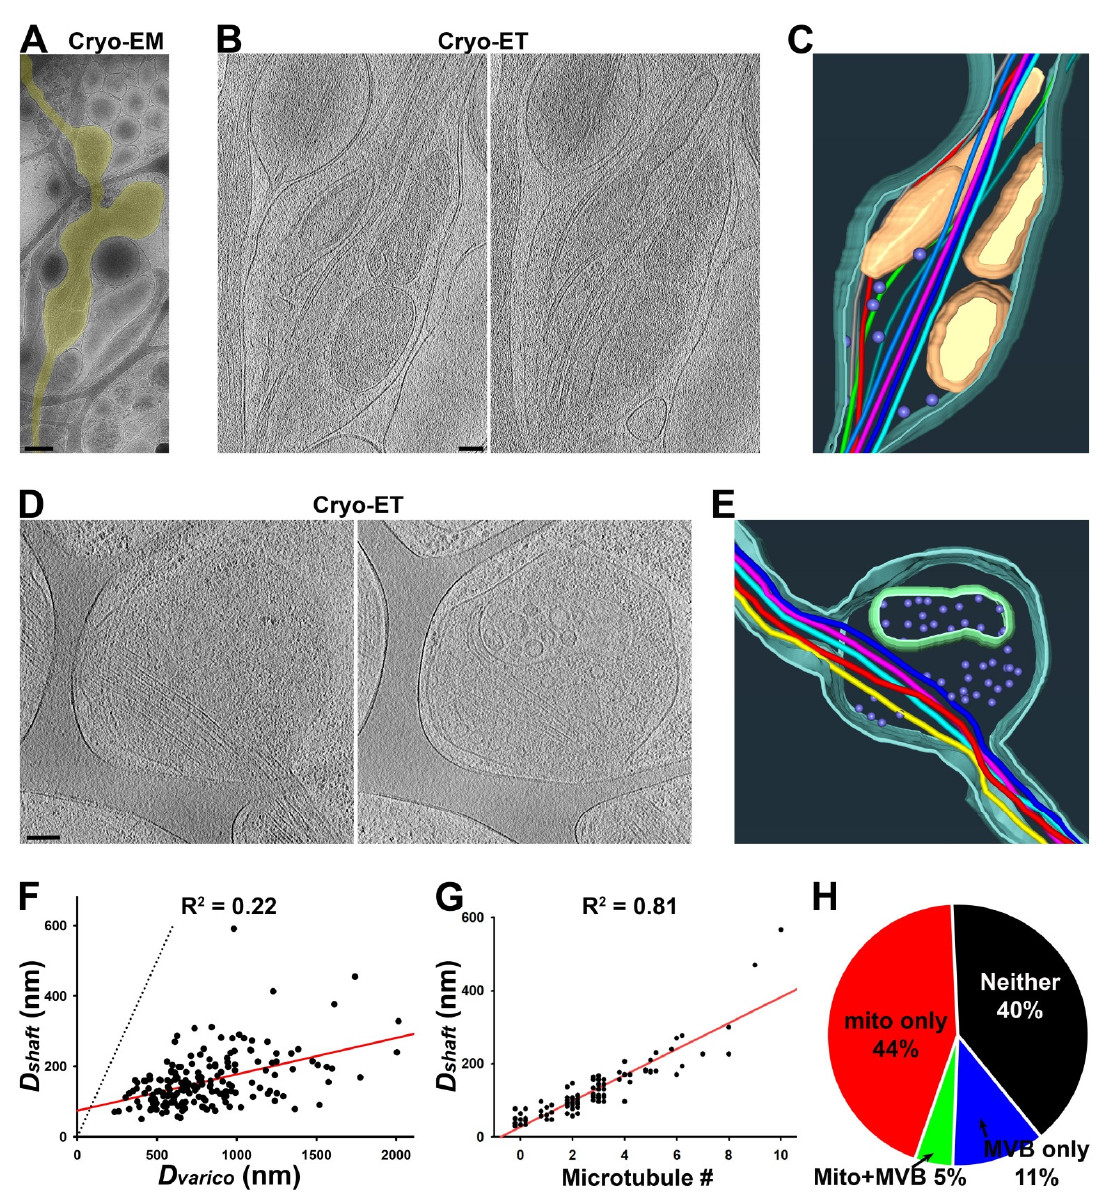
Figure 2. Three-dimensional ultrastructures of axonal varicosities on lacey carbon film revealed by Cryo-ET. ( A ) Low-magnification Cryo-EM image of an axon (highlighted in yellow) growing on lacey carbon film. ( B ) Two slices from the Cryo-ET tomogram of the axonal varicosity. ( C ) Segmentation view of the varicosity in ( B ). MTs were represented in tubes of different colors: mitochondria in yellow, plasma membrane in cyan, and small vesicles in purple. ( D ) Two slices from the Cryo- ET tomogram of an axonal varicosity containing an MVB. ( E ) Segmentation view of the varicosity in ( D ). The outer membrane of the MVB is in green. ( F ) The correlation between the diameter of the axonal varicosity (D varico ) and the diameter of its nearby shaft growing on top of carbon fiber (D shaft ). ( G ) The correlation between the diameter of the axonal shaft (D shaft ) and the number of its MTs. ( H ) Percentages of axonal varicosities containing mitochondria but not an MVB (red, 44%), MVB(s) but no mitochondria (blue, 11%), both mitochondria and an MVB (green, 5%), and neither mitochondria nor an MVB (black, 40%). n = 191. Scale bars, 500 nm in ( A ) and 100 nm in ( B , D